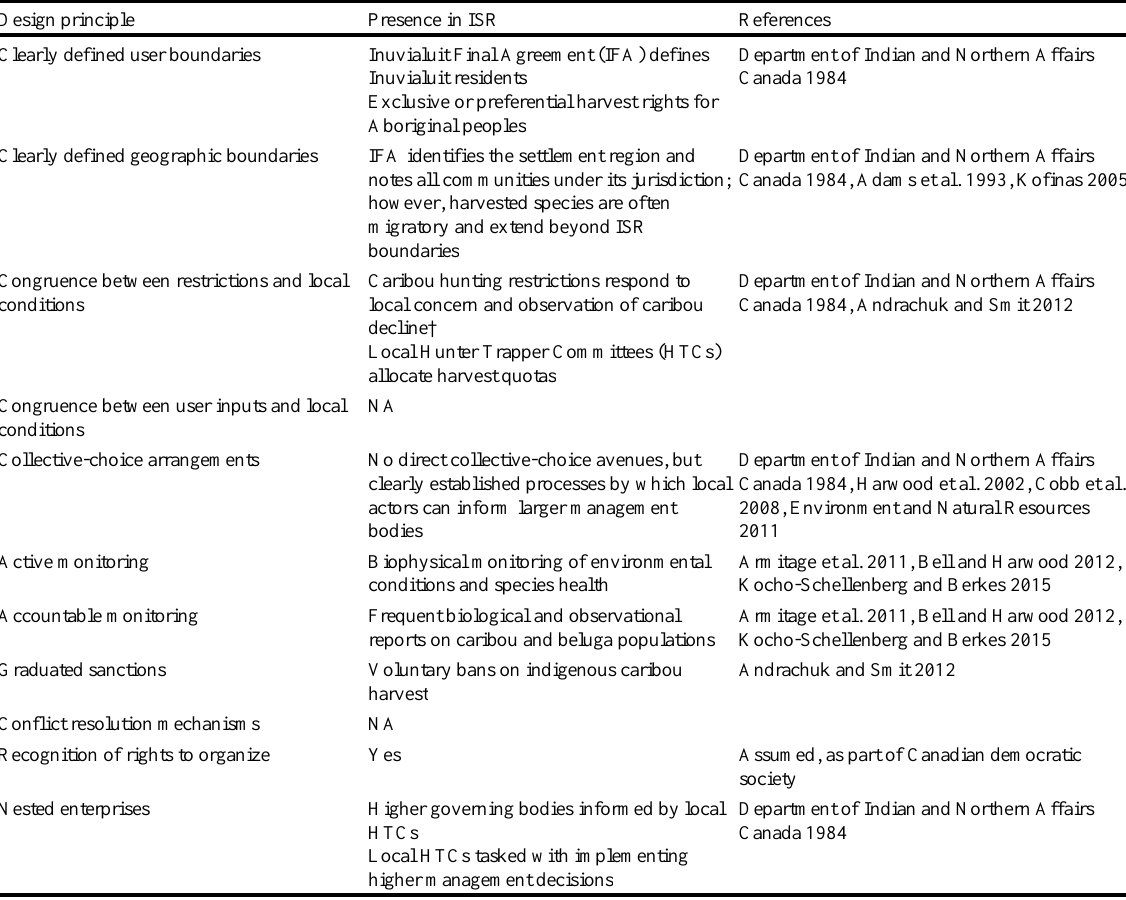
Table 4 . Design principles (Cox et al. 2010) and their presences in the Inuvialuit Settlement Region (ISR) (Department of Indian and Northern Affairs Canada 1984). NA indicates not enough information to determine the presence of a design principle in the study area. Design